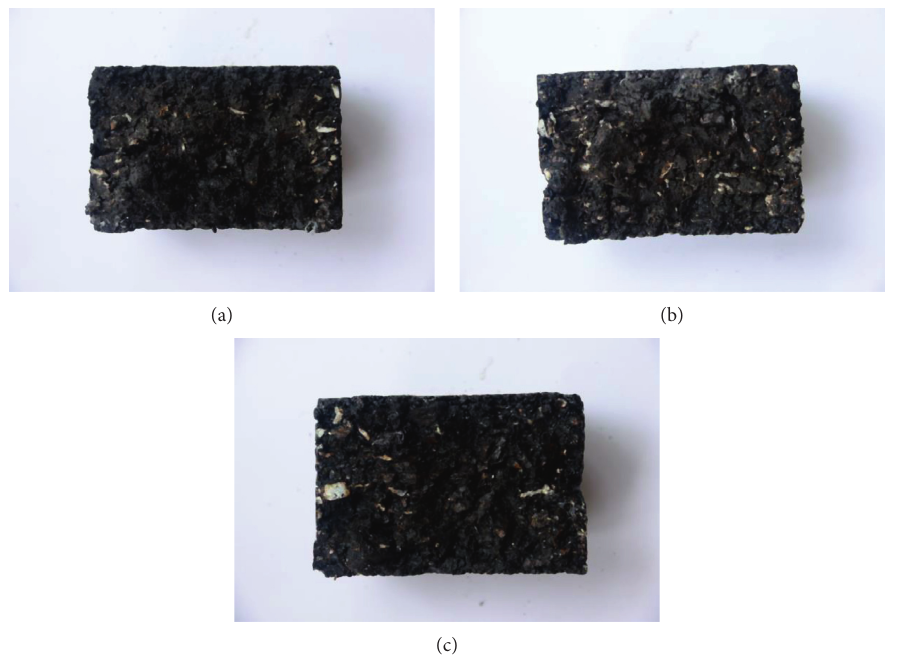
Figure 10: Post median filter-sample specimen of HMA. (a) Dry-HP180, (b) 1FT-HO180, (c)